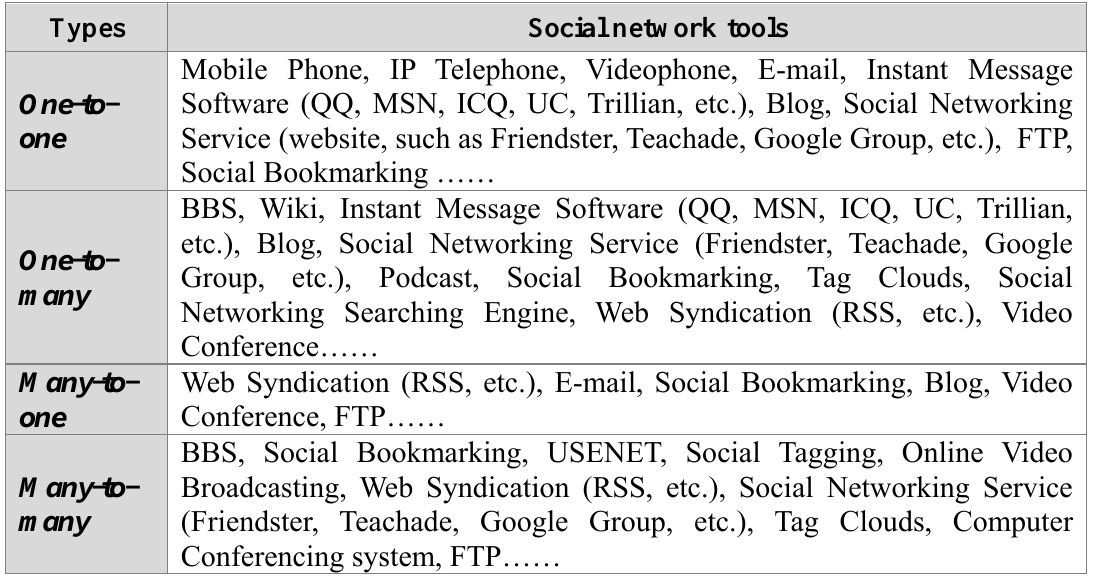
Table 3: Four types of distant interaction and social networking tools